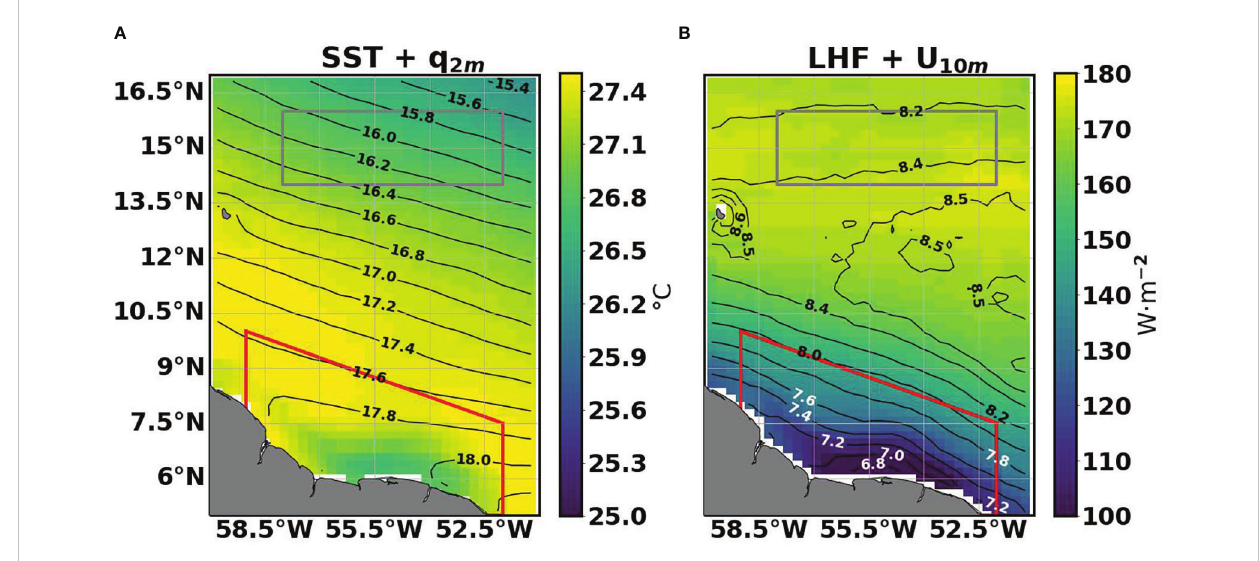
near-surface wind speed (in m s -1 , white color is used close to the coast to facilitate visualization). In both maps the gray box delimits the OOR (14°-16°N, 58°-52°W) and the red box represents the ECR. Daily values between 2008 to 2018 are considered to compute the